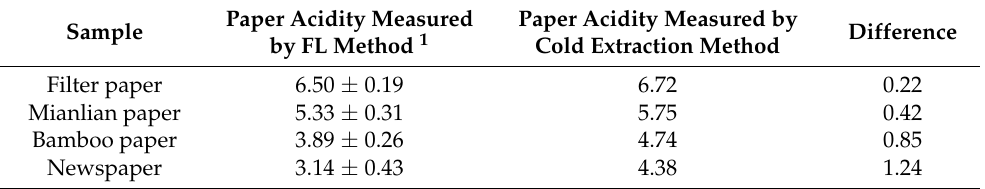
Table 2. The acidity of paper-based relics detected by two